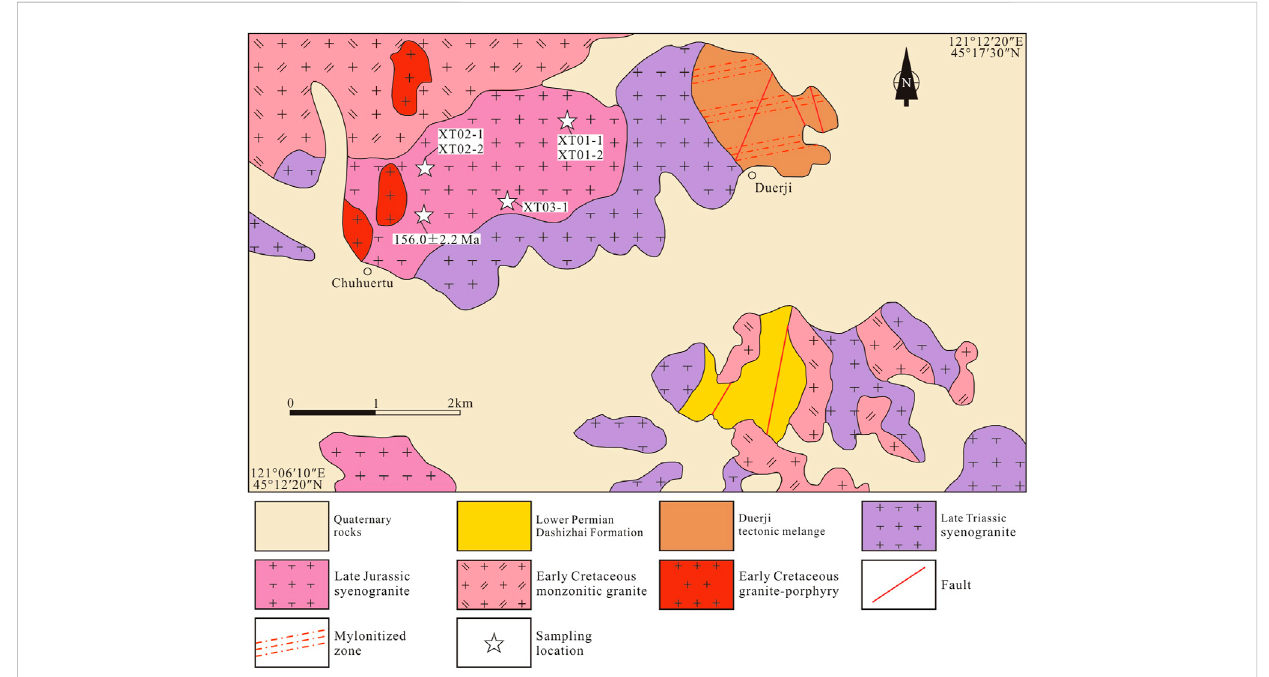
FIGURE 2 Simpli fi ed geological map of the Chuhuertu region in Horqin Right Middle Banner, Inner Mongolia.